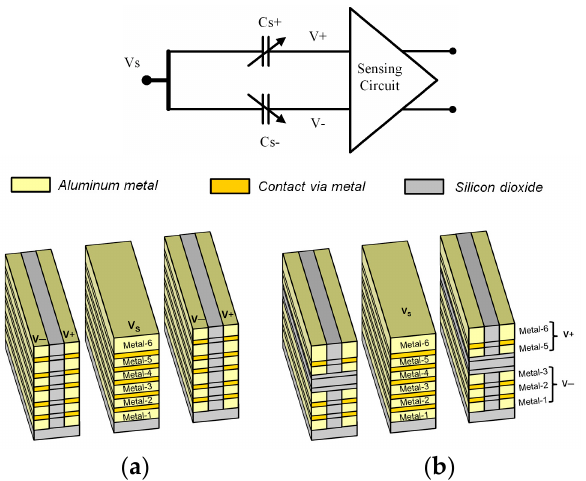
Figure 3. CMOS stacked layers for differential electrodes ( a ) in-plane, and ( b ) z -axis